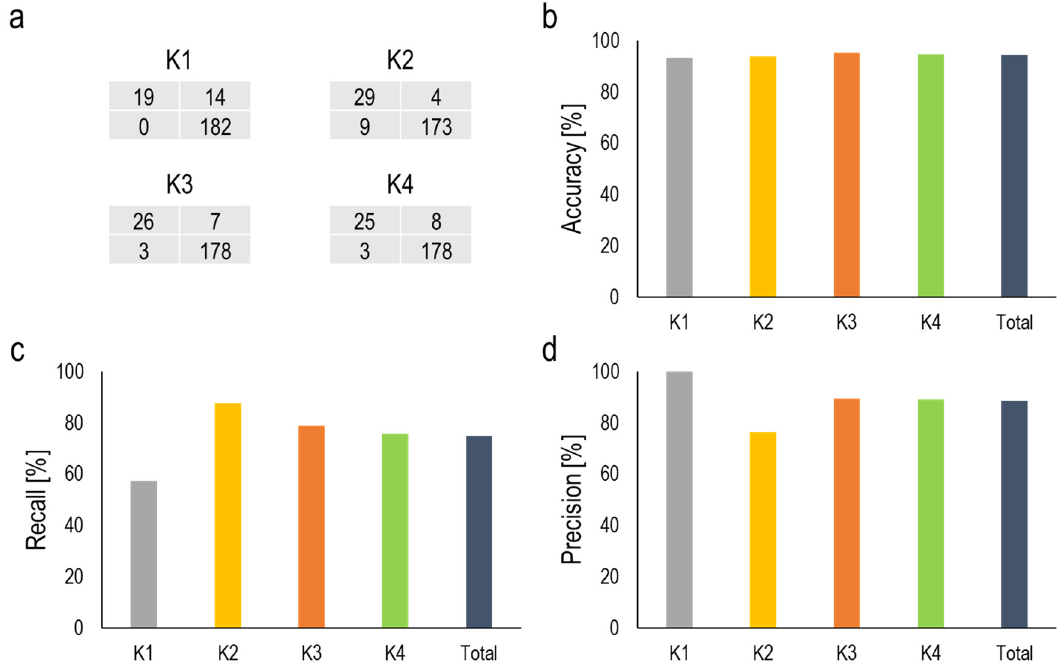
Figure 15. ( a ) Confusion matrix; ( b ) accuracy; ( c ) recall; ( d )